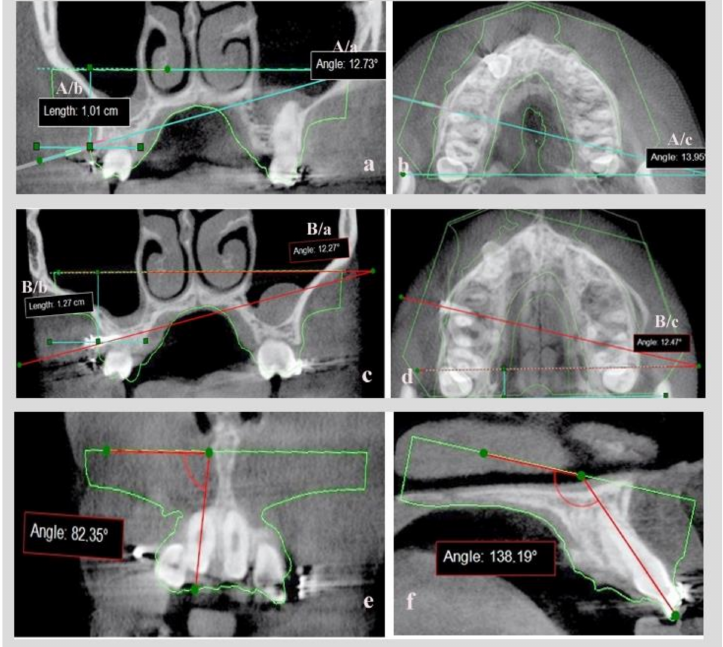
Figure 5. ( a ) Coronal slice (measurement set A/a, A/b). ( b ) Axial slice (measurement set A/c) for evaluating virtual mini-implant’s position. ( c , d ) Coronal and axial slice for evaluating the real mini-implant’s position (measurement set B/a, B/b, B/c). ( e ) Angle of axial line of central upper right incisor and the base of the STL model in coronal slice. ( f ) Angle of the axial line of the central upper right incisor and the base of the STL model in a sagittal